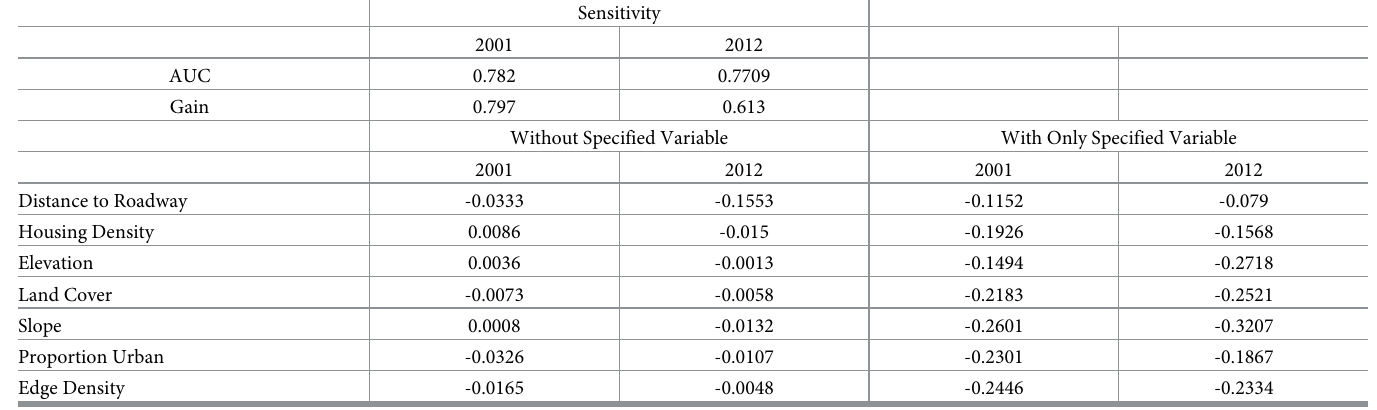
Table 4. IP Sensitivity and deviation from model